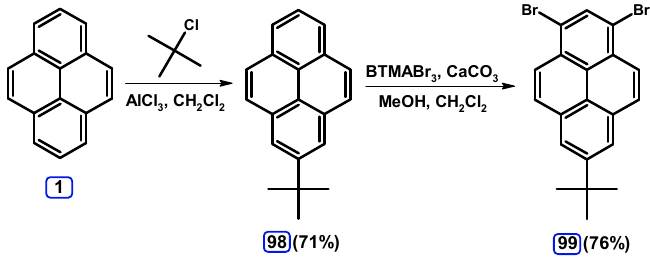
Scheme 52. Introduction of protecting tert -butyl group [79].